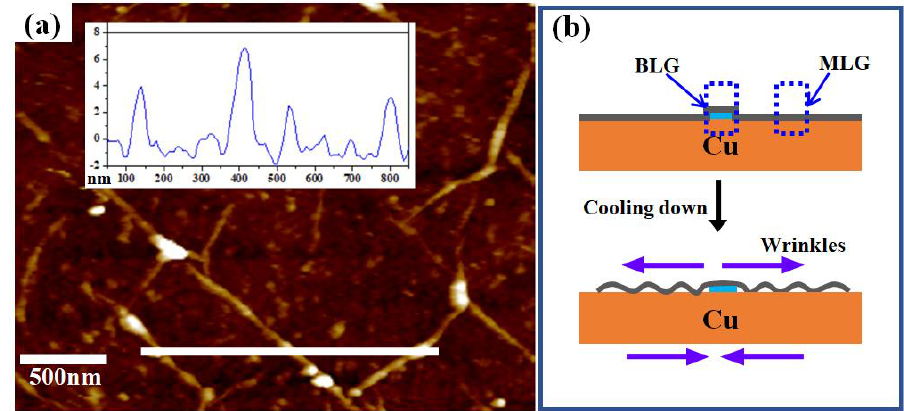
Figure 2. ( a ) AFM image of wrinkled graphene transferred onto SiO 2 / Si and the inset is the height of the thick, white line-marked region. ( b ) Schematic diagrams showing the effect of thermal expansion mismatch on the formation of wrinkles in monolayer graphene (MLG) and bilayer graphene (BLG) areas.